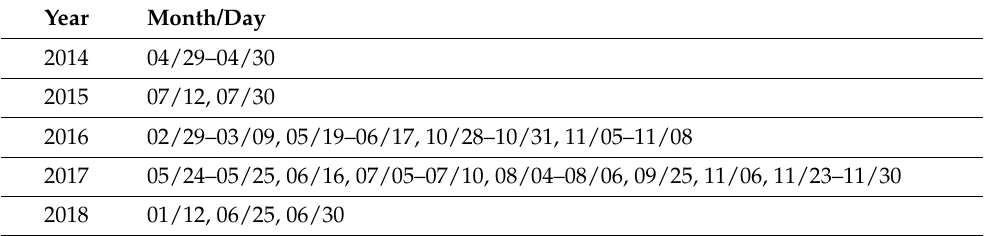
Table 1. KPOL data gaps from April 2014 to June 2018 with length of at least one day.